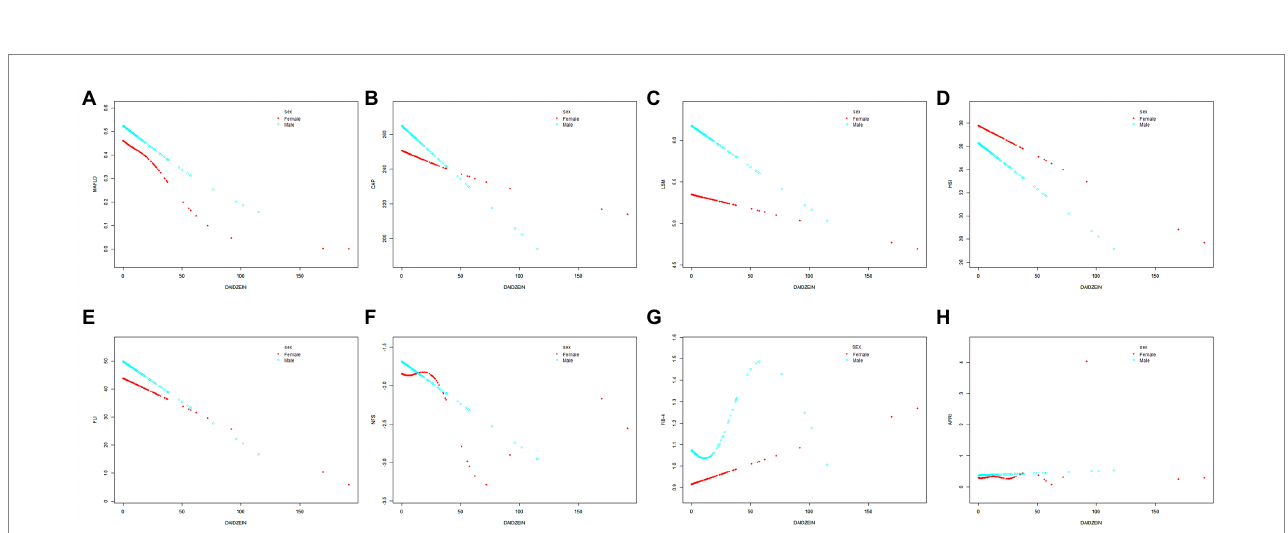
FIGURE 3 The relationship between daidzein intake and MAFLD prevalence, CAP, LSM, HSI, FLI, NFS, FIB-4, and APRI stratified by gender, respectively. The relationship between daidzein intake and MAFLD prevalence (A) , CAP (B) , LSM (C) , HSI (D) , FLI (E) , NFS (F) , FIB-4 (G) , and APRI (H) stratified by gender, respectively. Age and race/ethnicity were adjusted in the model. MAFLD, metabolic associated fatty liver disease; CAP, controlled attenuation parameter; LSM, liver stiffness measurement; HSI, hepatic steatosis index; FLI, fatty liver index; FIB-4, fibrosis-4; NFS, NAFLD fibrosis score; APRI, AST to platelet ratio